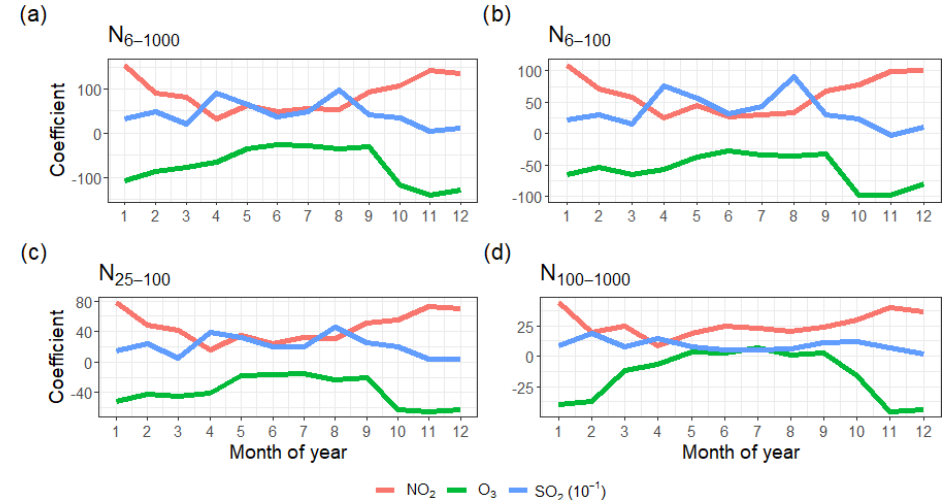
Figure 4. Distribution of monthly-mean coefficients (which are proportional to the partial effects) for NO 2 , O 3 and SO 2 on particle number concentrations separately in the diameter ranges from 6 to 1000nm ( N 6 − 1000 ), from 6 to 100nm ( N 6 − 100 ), from 25 to 100nm ( N 25 − 100 ) and from 100 to 1000nm ( N 100 − 1000 ).